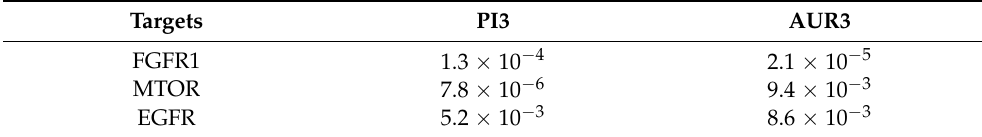
Table 6. Binding site similarities between different targets. SMAP p -values represent the similarities and the lower the SMAP p -value, the more similarity between different targets.